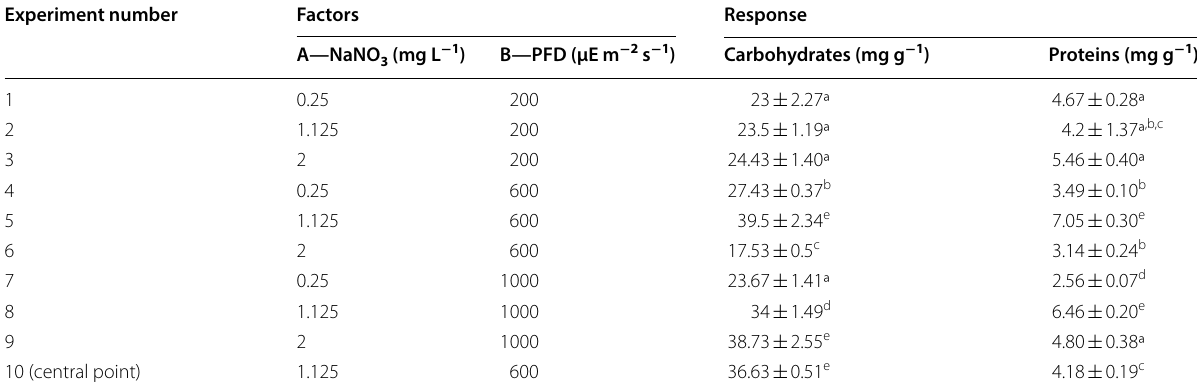
Statistical differences (One-way ANOVA followed by Tukey’s test; p < 0.05) among conditions are represented as different